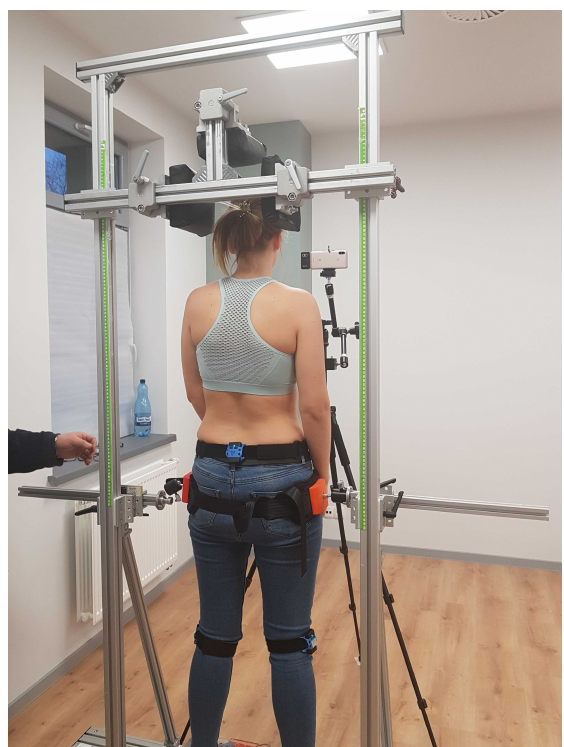
Figure 2. During exercises in the standing position in the D4S module, the head is restrained from two sides to prevent sideways movements; pelvis is restrained by a belt to allow only anterior and posterior